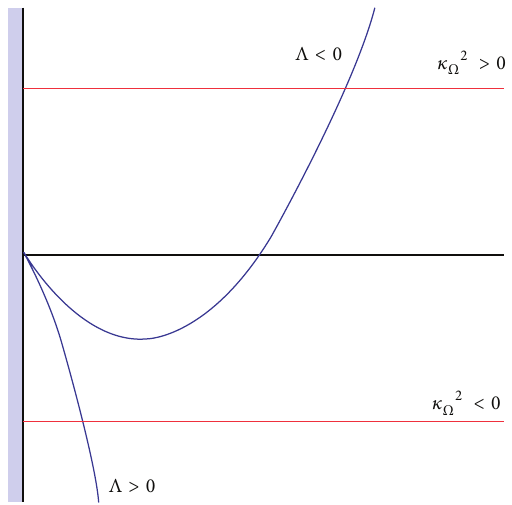
Figure 1: Plot of (39), considering different classes of total energy, in the 𝜅 Ω 2 parameter. Also, we include two branches in the cosmo- logical